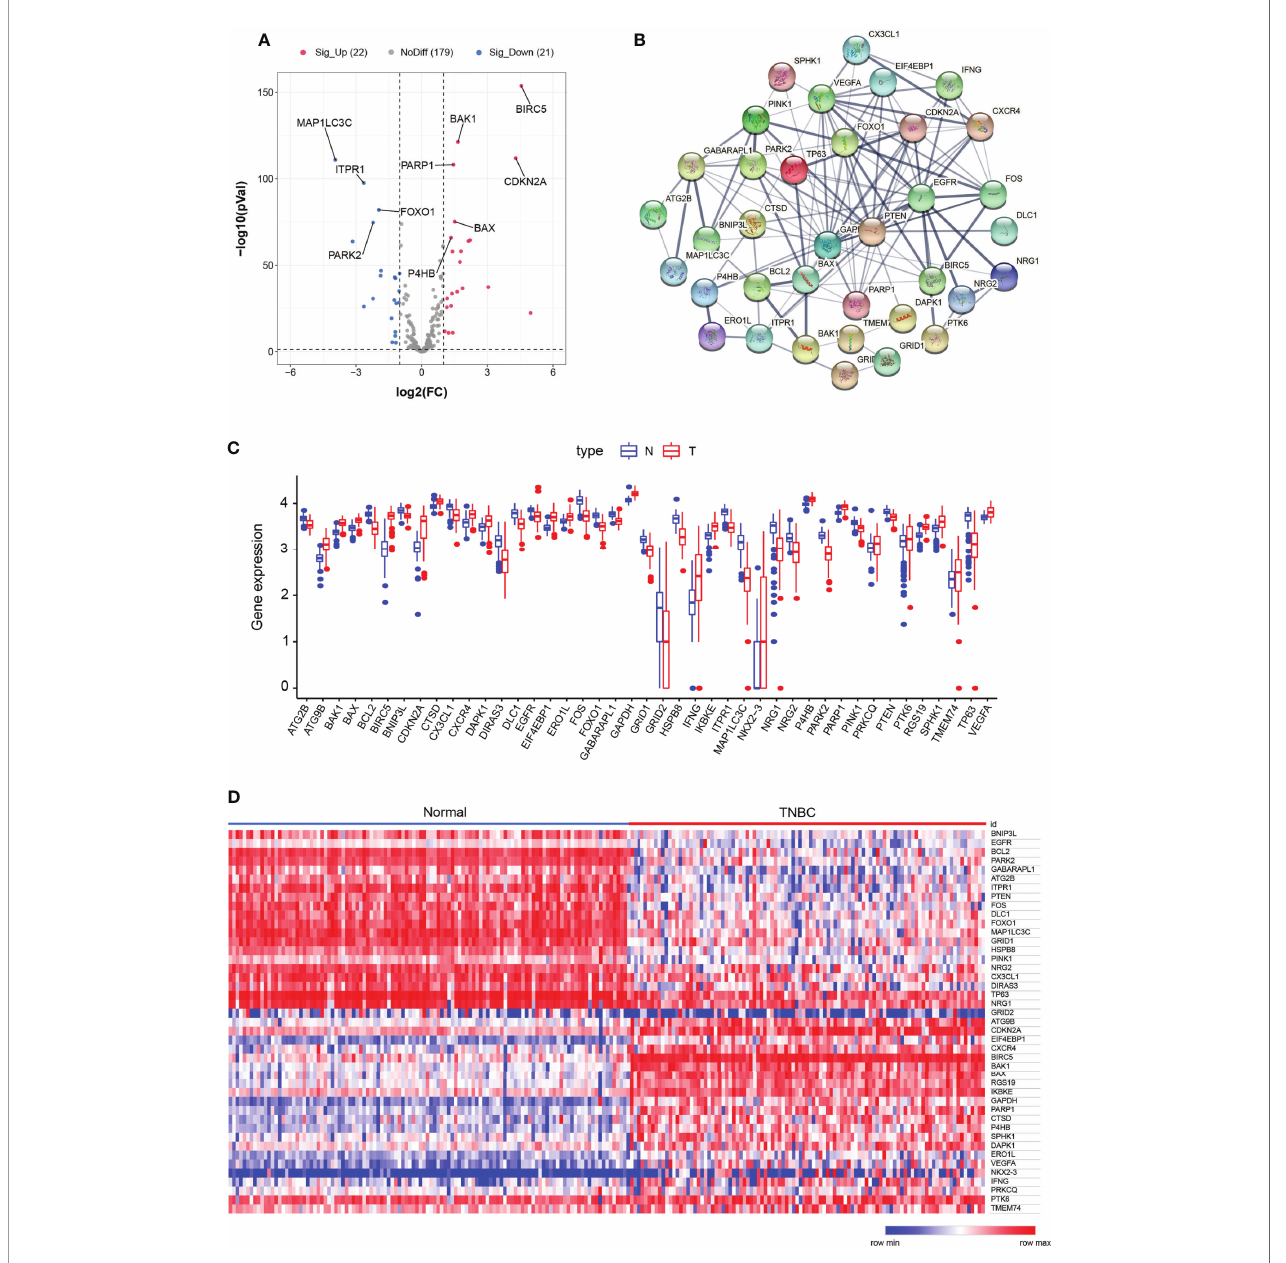
FIGURE 2 | Differentially expressed autophagy-related genes. (A) Volcano map showed differentially expressed genes between normal samples and TNBC samples. Red dots represent signi fi cantly upregulated genes, blue dots represent signi fi cantly downregulated genes, and gray dots represent ARGs with no difference. (B) Protein – protein interactions (PPI) network of ARGs using the STRING database. (C) Box plots showed gene expression values of ARGs. Blue represents normal samples, and red represents tumor samples. (D) Heatmap showed the expression levels of ARGs. The color scale represented the expression levels normalized by